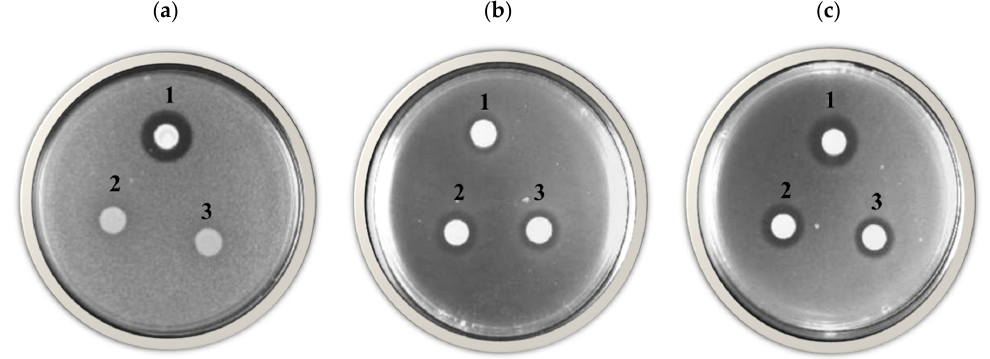
Figure 2. Growth inhibition activity of Candida pyralidae Y1117 (1), Pichia kluyveri Y1125 (2) and P. kluyveri Y1164 (3) against Zygosaccharomyces baillii ( a ), Dekkera bruxellensis ( b ) and Dekkera anomala ( c ) on grape pomace extracts agar medium.